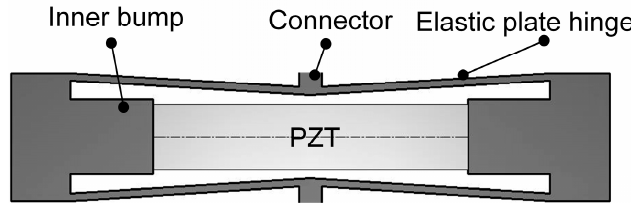
Figure 3. Hourglass displacement amplification mechanism.